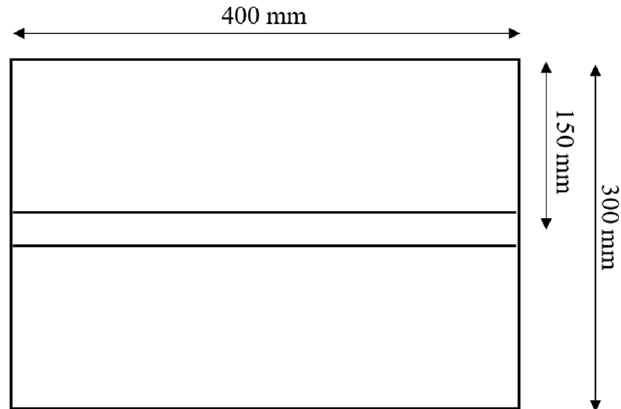
Figure 5. Cutting specimen dimension.